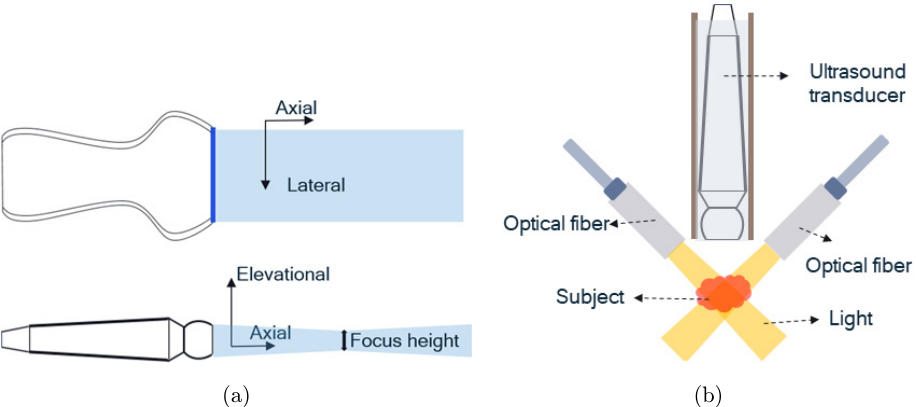
Fig. 1. Schematic drawing of a linear array transducer. (a) Top: Imaging plane of the linear array transducer. Bottom: Side view of the focal zone of the linear array transducer. (b) Light delivery scheme for side-illumination